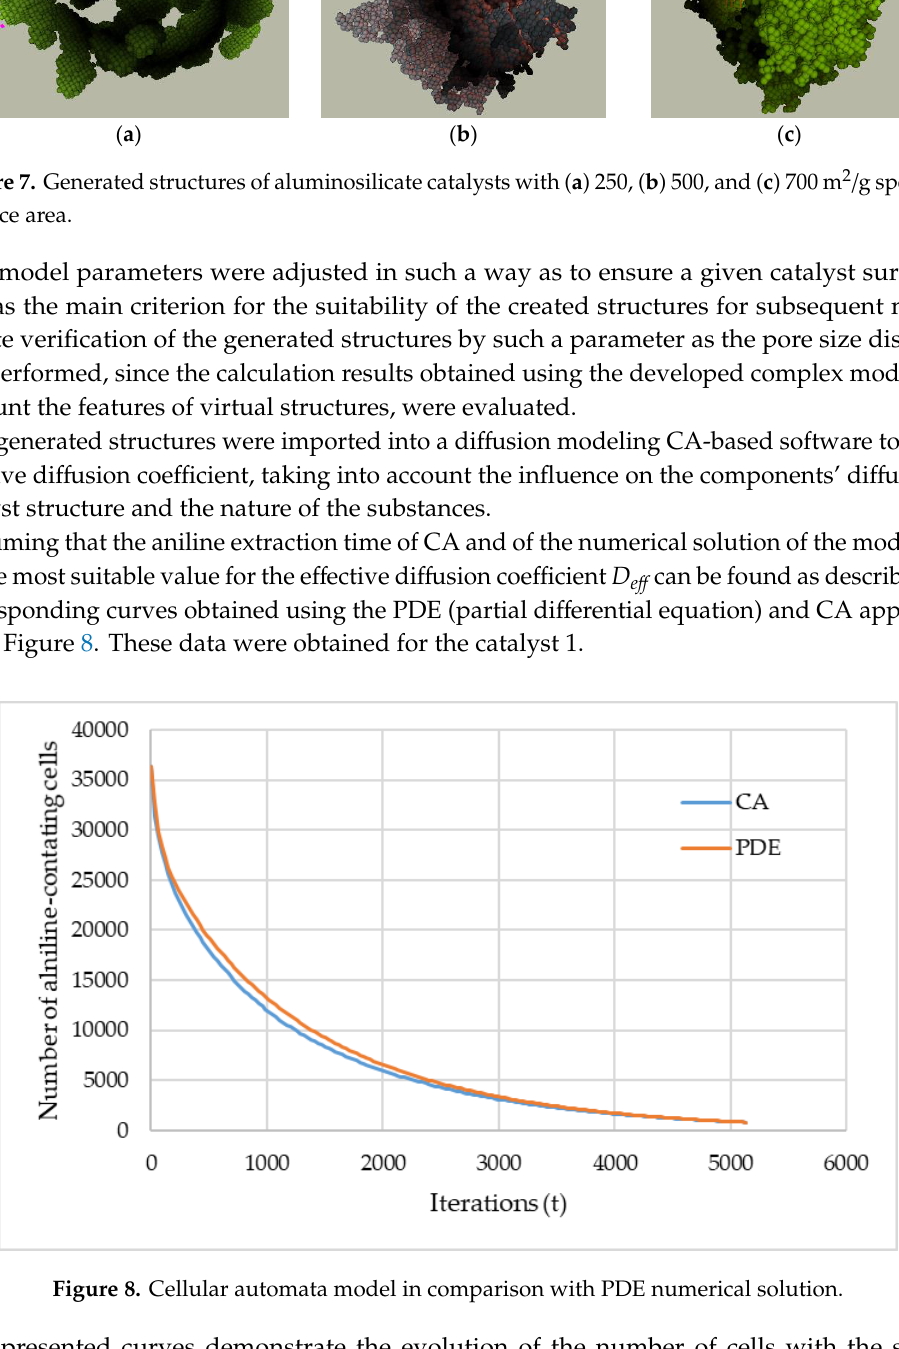
Figure 8. Cellular automata model in comparison with PDE numerical solution.